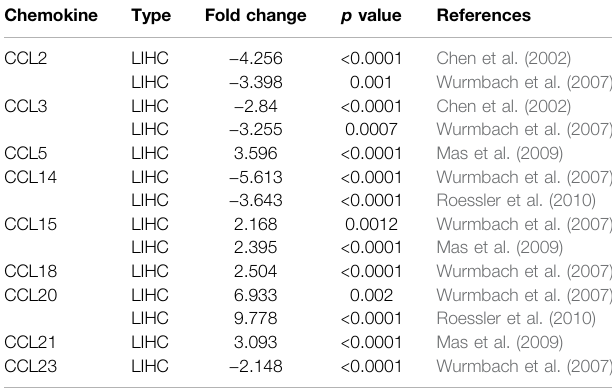
TABLE 1 | The mRNA levels of aberrantly expressed chemokines CCL in LIHC tissues and normal liver tissues at transcriptome level (ONCOMINE).